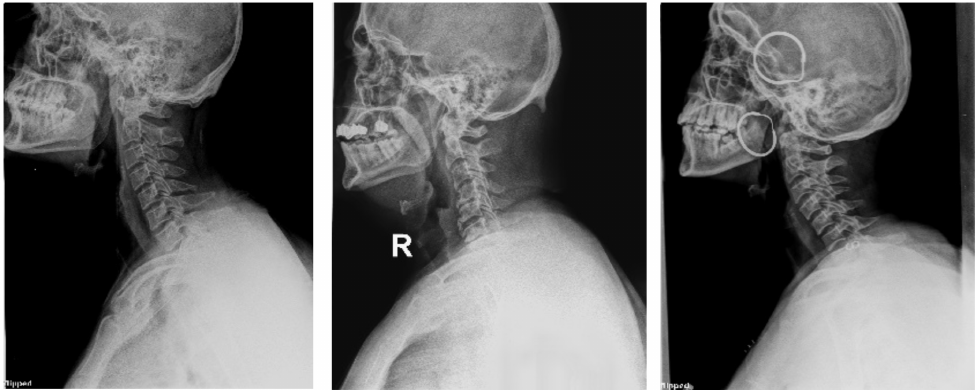
Figure 12. X-ray images for the normal